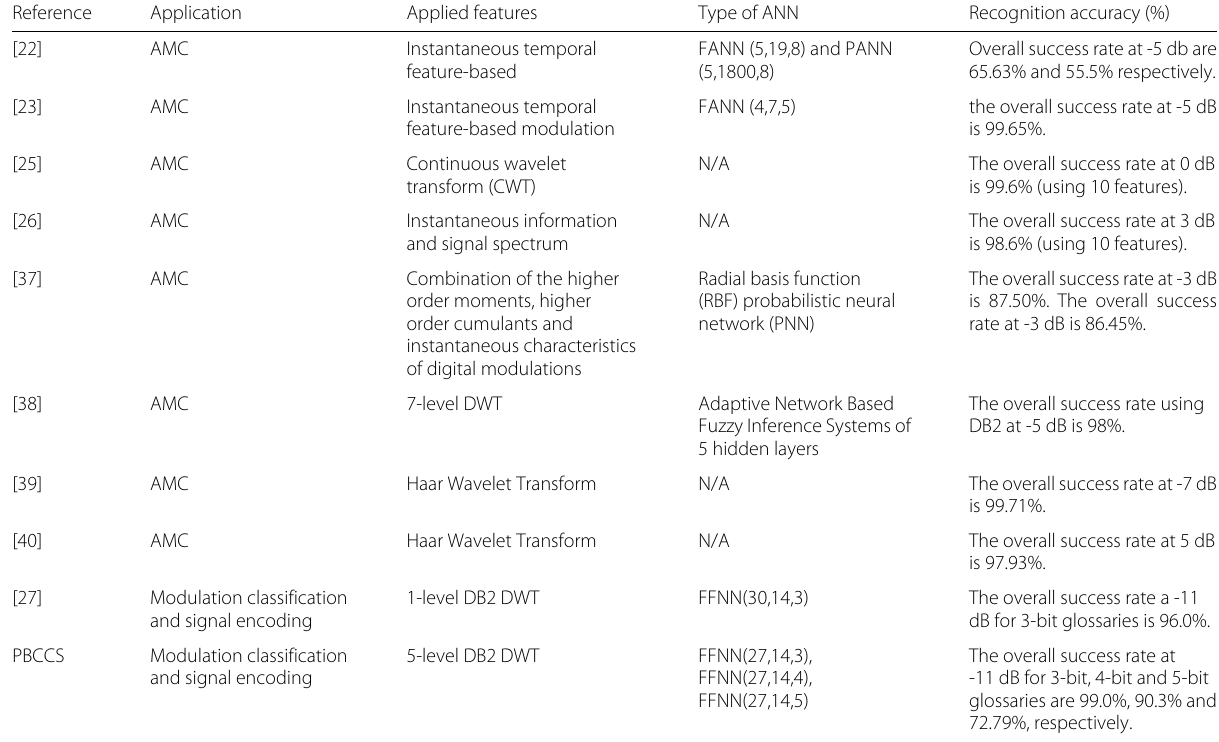
Table 7 Comparison between different works in terms of features, ANN model and the achieved SNR with the recognition accuracy